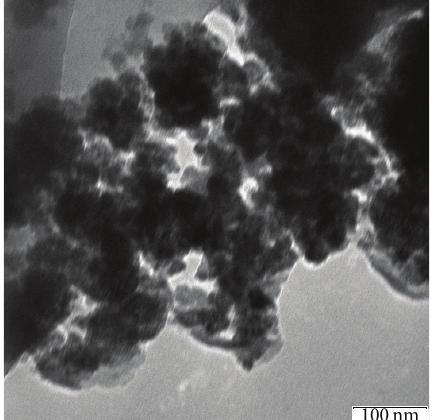
Figure 2: TEM micrograph of 𝛼 -Fe 2 O 3